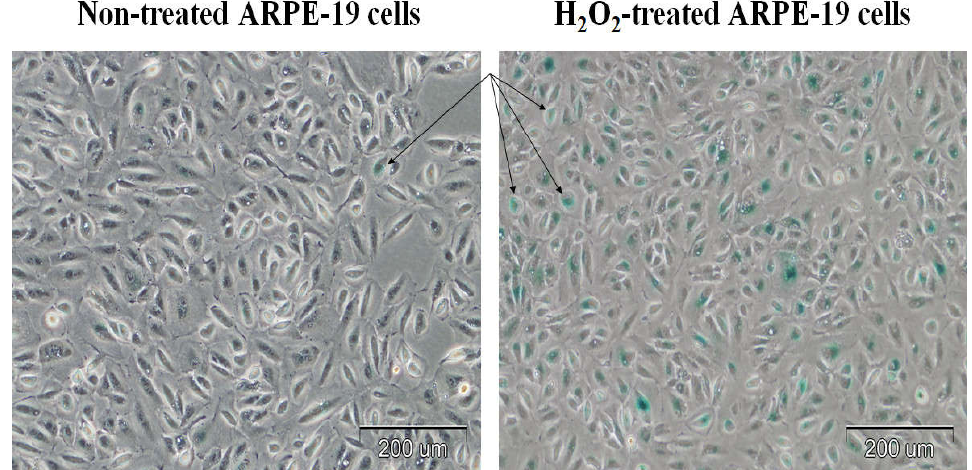
Figure 2. Non-treated and H 2 O 2 -treated ARPE-19 cells stained for senescence-associated β-galactosidase activity. The cells were treated with H 2 O 2 at a concentration of 400 µM for 60 min. The arrows indicate blue SA-β-gal-positive cells.